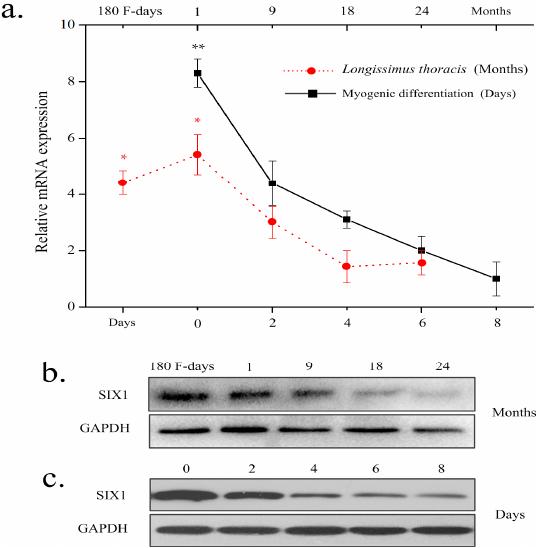
Figure 1. Expression pattern analysis of bovine SIX1 . ( a ) SIX1 mRNA expression was determined at different developmental stages. The samples of the longissimus thoracis were obtained at 180 days in utero and at 1, 9, 18, and 24 months after birth (red line) and the bovine myoblasts after the induction of myogenic differentiation at Day 0 (D0), Day 2 (D2), Day 4 (D4), Day 6 (D6), and Day 8 (D8) (black line). GAPDH was used as a housekeeping gene; ( b , c ) Protein expression pattern of bovine SIX1 was detected in different stages of development and myogenesis. The results are expressed as the means ± SD. “*” p < 0.05 and “**” p < 0.01.